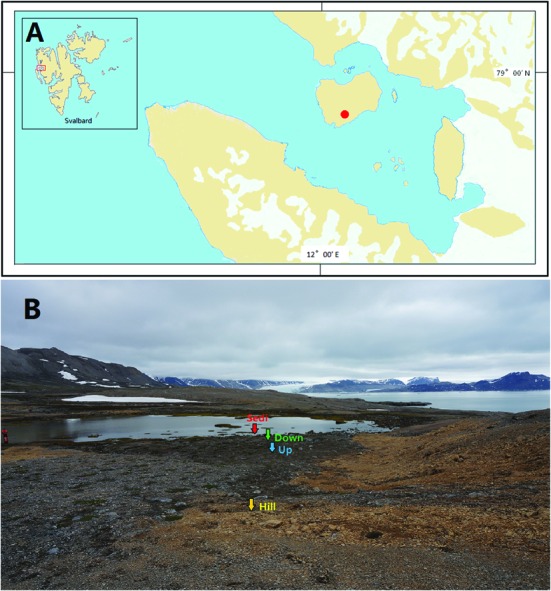
Location (red dot; A) and image (B) of the sampling sites from an Arctic lake area in the present study.